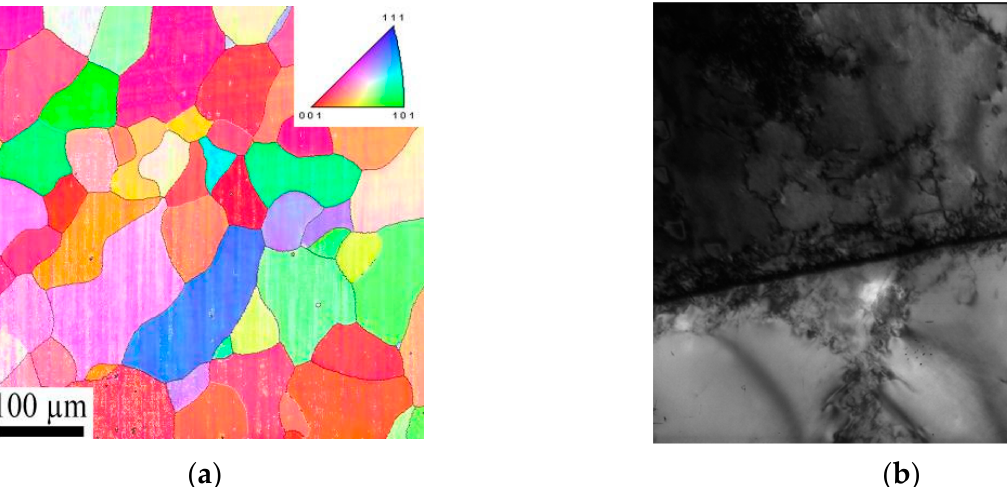
Figure 8. Microstructure of ARMCO iron in the initial state after the fatigue test: ( a ) EBSD IPF map and ( b ) TEM images; the bottom edge of the EBSD map corresponds to the surface of the specimen.